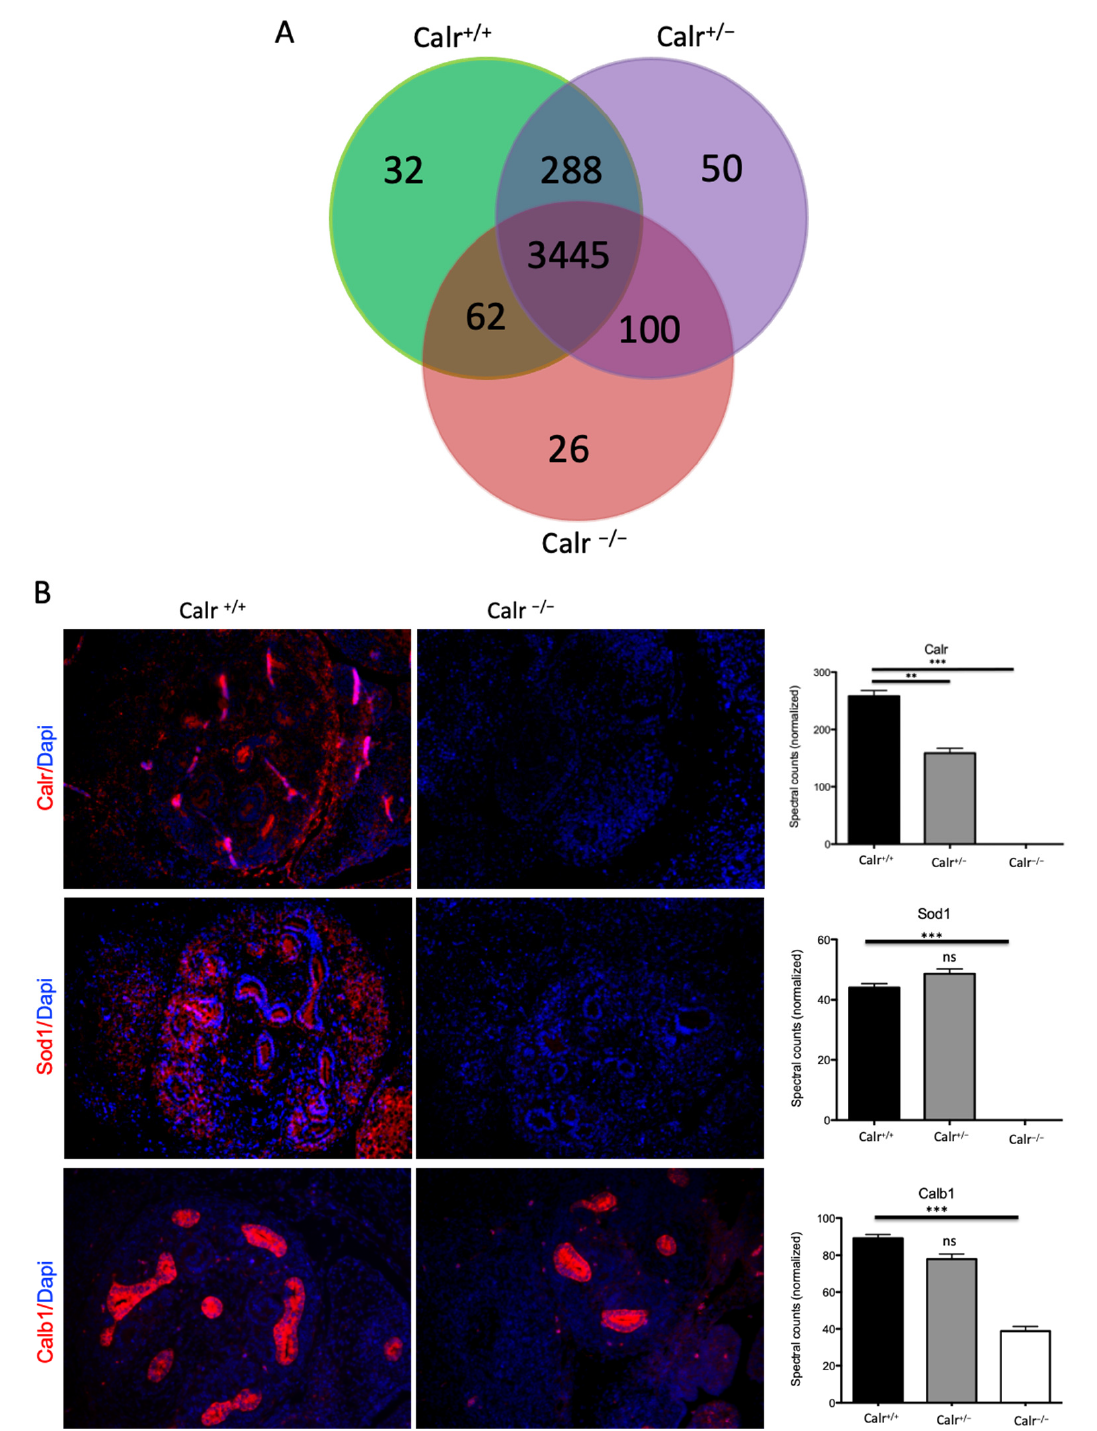
Figure 5. Investigation of the proteome alteration in Calr deficient embryonic kidney. The embryonic kidney proteome was analyzed by combining 1DE and mass spectrometry. ( A ): A Venn diagram illustrating the distribution of proteins identified in different kidney genotypes. The Venn diagram shows the proteins common in all three groups or in two groups and highlights proteins expressed in only one of the groups. ( B ): Immunofluorescence staining and mass spectrometric quantification of selected proteins down-regulated in Calr − / − compared to Calr +/+ and Calr +/ − . Significant differences were accorded to: (**) p < 0.01, (***) p < 0.001.